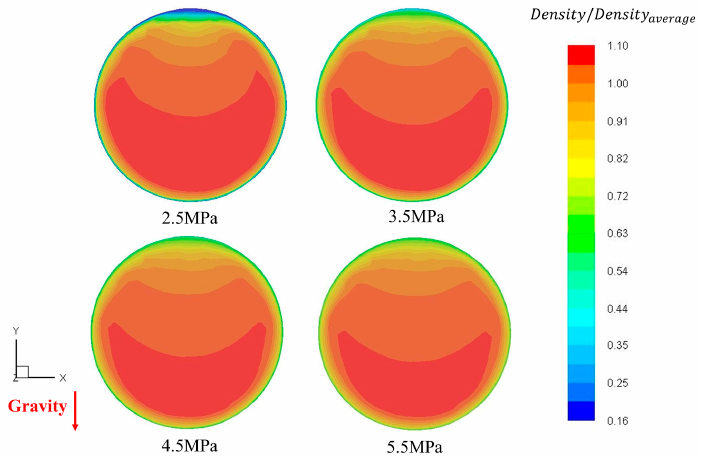
Figure 11. Distributions of density / density average at cross-section Z = 125 mm under different pres- Figure 11. Distributions of 𝑑𝑒𝑛𝑠𝑖𝑡𝑦/𝑑𝑒𝑛𝑠𝑖𝑡𝑦 (cid:3028)(cid:3049)(cid:3032)(cid:3045)(cid:3028)(cid:3034)(cid:3032) at cross-section Z = 125 mm under different sures (numerical results of Case Figure 11. Distributions of 𝑑𝑒𝑛𝑠𝑖𝑡𝑦/𝑑𝑒𝑛𝑠𝑖𝑡𝑦 (cid:3028)(cid:3049)(cid:3032)(cid:3045)(cid:3028)(cid:3034)(cid:3032) at cross-section Z = 125 mm under different pressures (numerical results of Case 3–6). pressures (numerical results of Case 3–6). Figure 11. Distributions of 𝑑𝑒𝑛𝑠𝑖𝑡𝑦/𝑑𝑒𝑛𝑠𝑖𝑡𝑦 (cid:3028)(cid:3049)(cid:3032)(cid:3045)(cid:3028)(cid:3034)(cid:3032) at cross-section Z = 125 mm under different pressures (numerical results of Case 3–6).